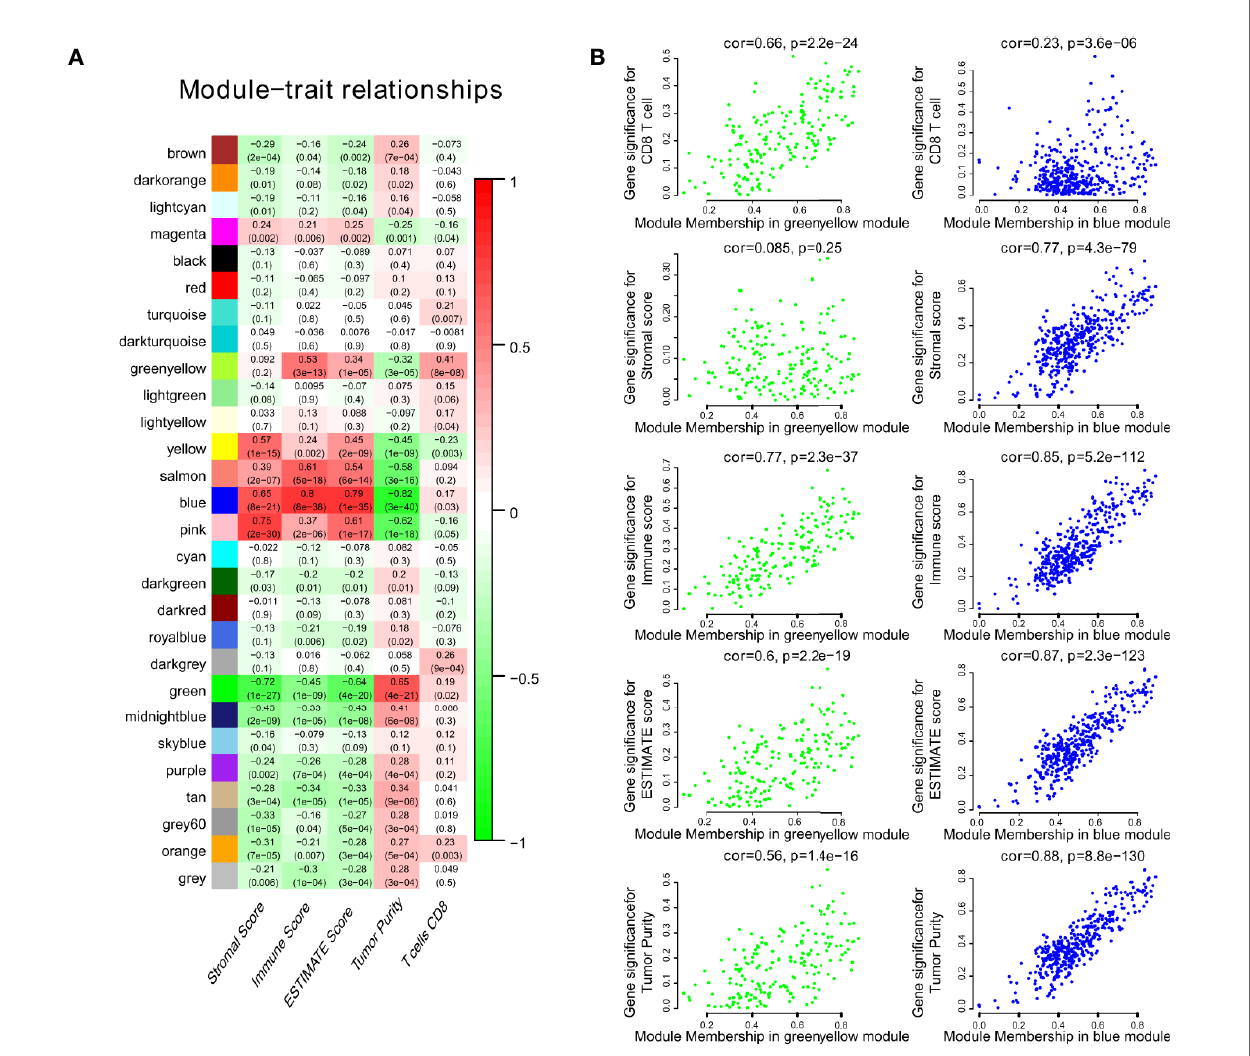
FIGURE 3 | The result of WGCNA. (A) The correlation coef fi cient between different phenotypes and co-expression modules were showed. (B) The blue module was highly correlated to stromal score (R 2 = 0.77, P = 4.3e -79 ), immune score (R 2 = 0.85, P = 5.2e -112 ), estimate score (R 2 = 0.87, P = 2.3e -123 ), and tumor purity (R 2 = 0.88, P = 8.8e -130 ), while the green-yellow module showed higher correlation with CD8 + T cells (R 2 = 0.66, P = 2.2e -24